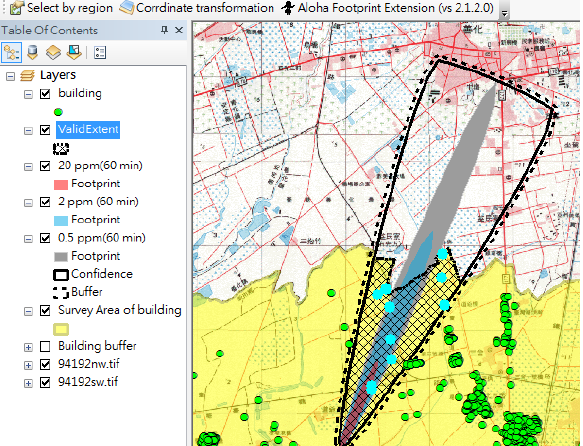
Figure 6: Valid extent of threat zone and selected building